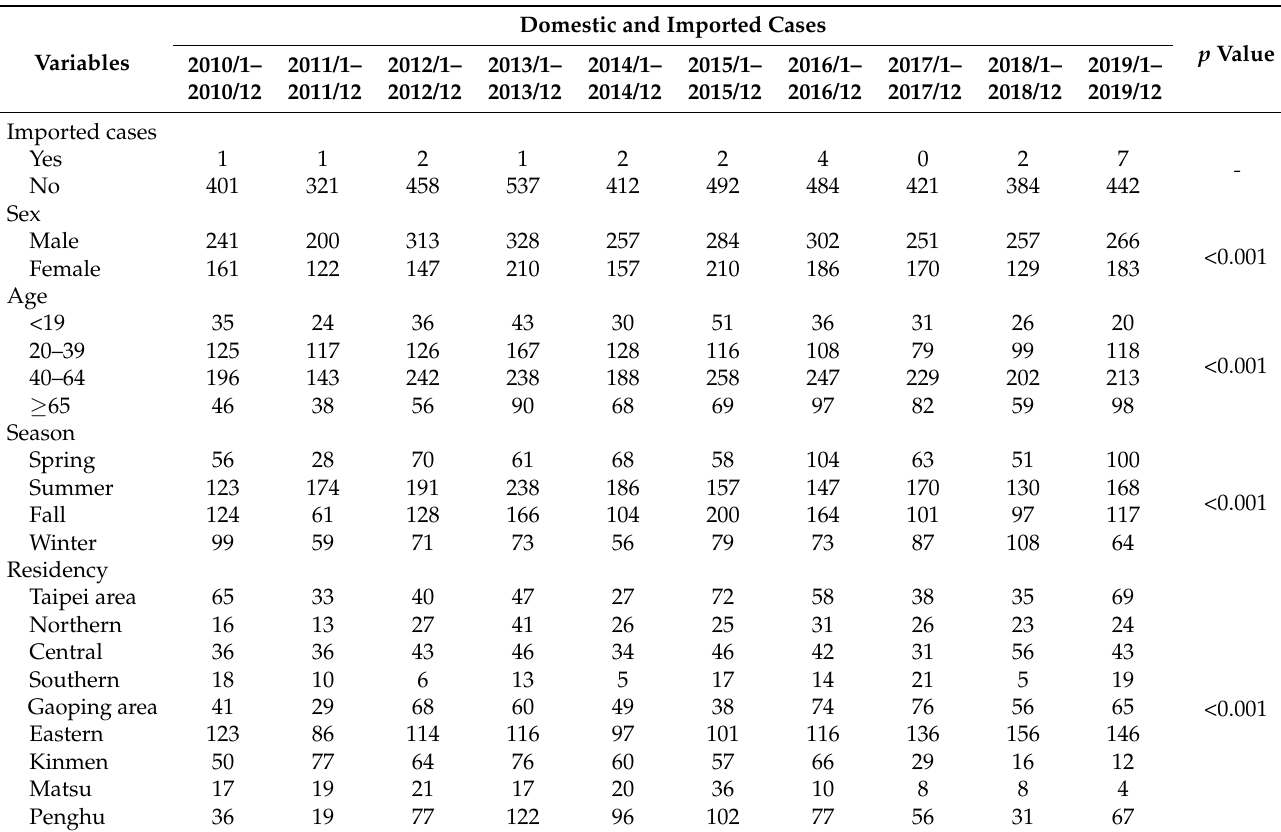
Table 2. The analysis of epidemiological features from a survey of domestic and imported cases of scrub typhus between 2010 and 2019 in